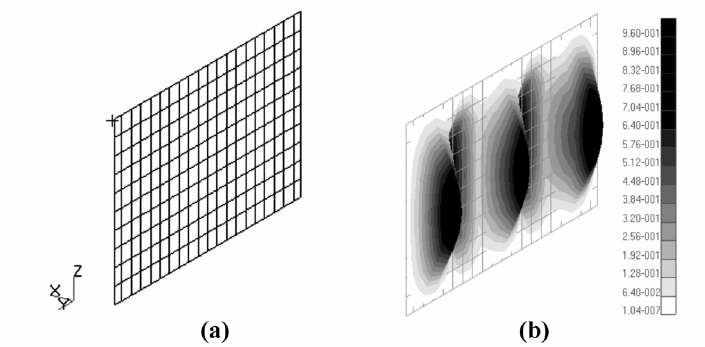
Fig. 3. Firewall: (a) FE mesh and (b) structural mode at 160 Hz [5;1].